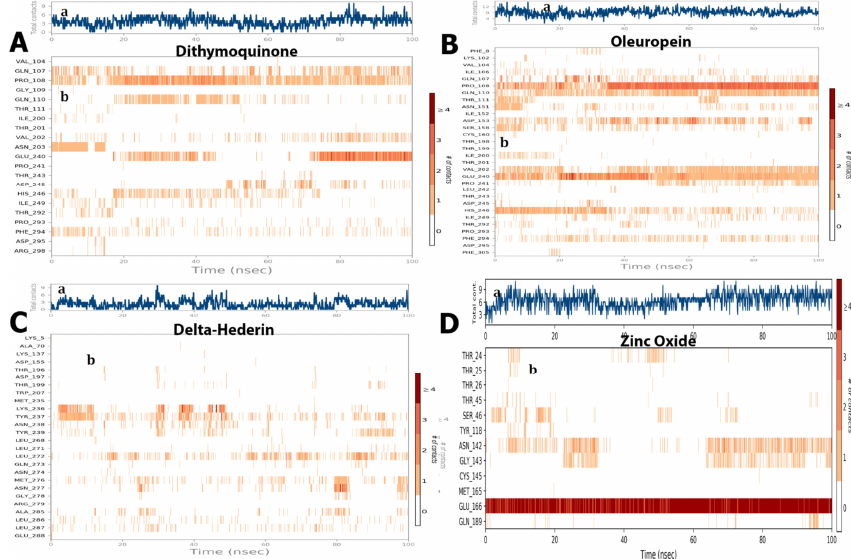
Figure 10. (a) The total number of contacts/interactions in each trajectory framework of four opti- mized compounds. ( A ) dithymoquinone, ( B ) oleuropein, ( C ) delta-hederin, ( D ) zinc oxide. Interaction is represented by the effective site of amino acids in each trajectory framework of the four optimized four compounds. (b) Hydrogen bonding interaction (% age) of residue Glu166 during the